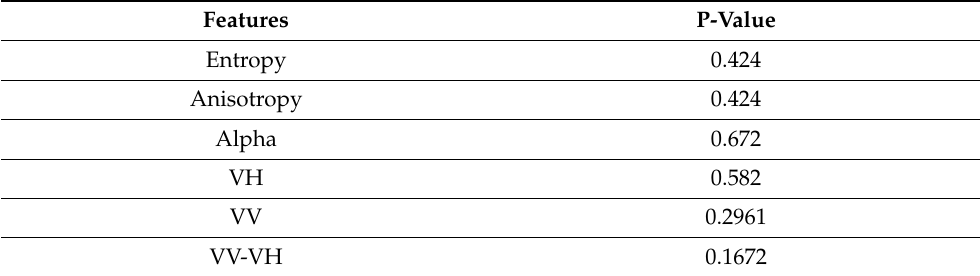
Table 2. Results of Kruskal–Wallis rank sum